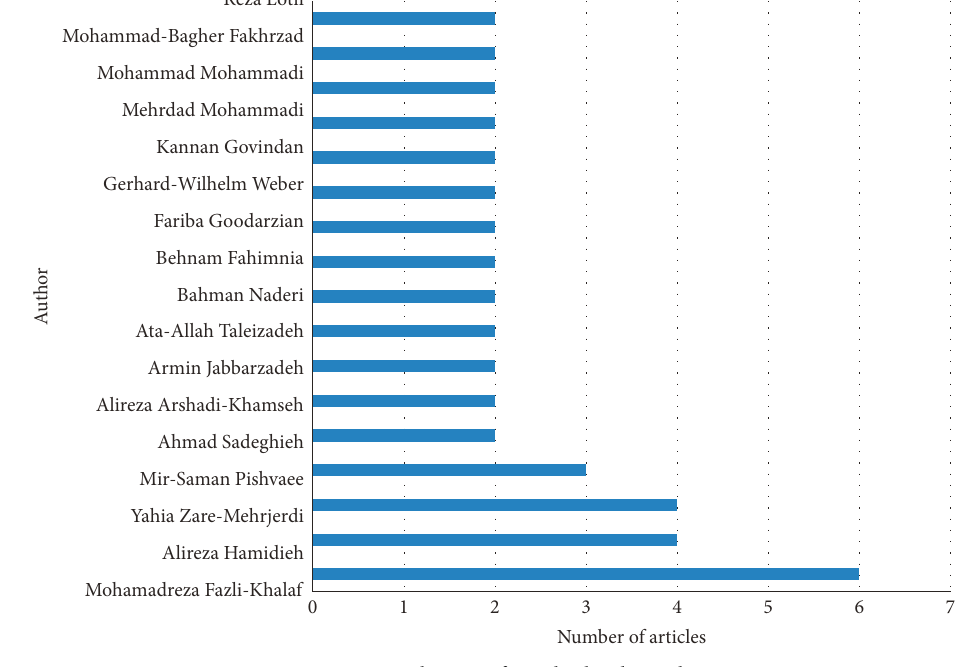
Figure 6: Distribution of articles by the author.